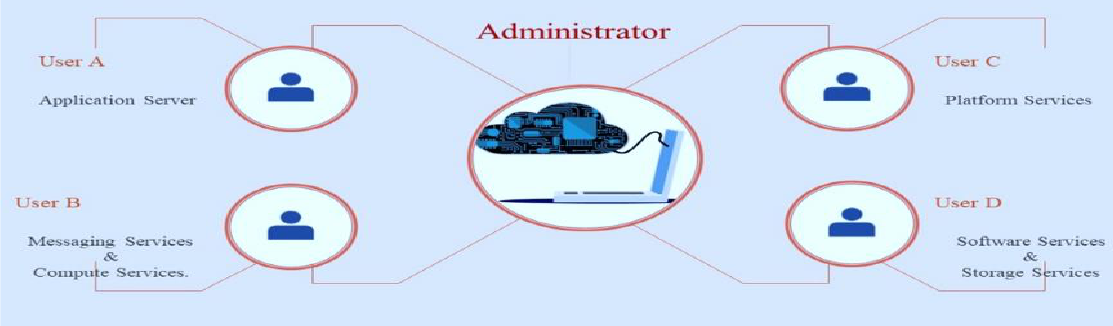
Figure 3. Private cloud computing.